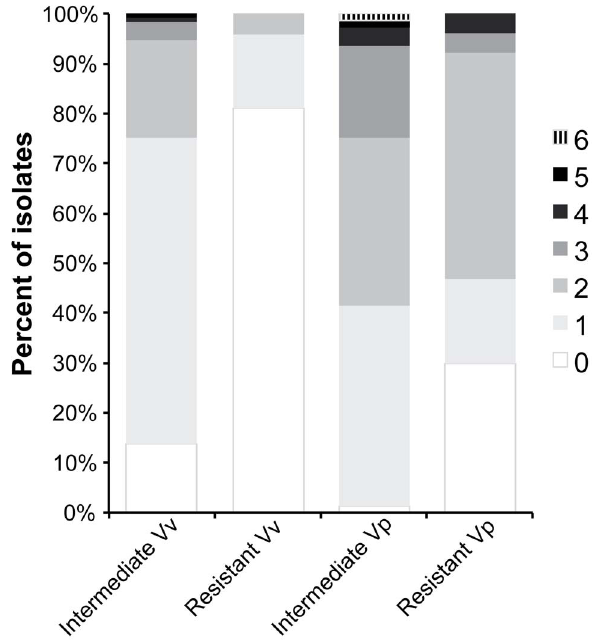
Figure 3. Number of antibiotics against which Vibriovulnificus (Vv)andVibrioparahaemolyticus(Vp) isolates expressed resis- tance or intermediate resistance.